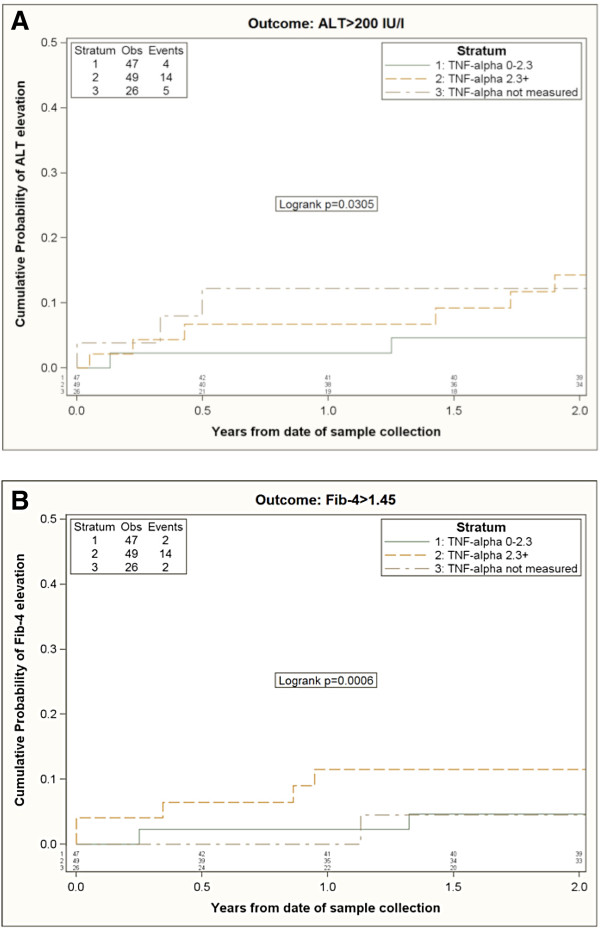
Kaplan-Meier estimates of the risk of ALT elevation (A) and Fib-4 elevation (B) according to TNF-alpha strata. Kaplan-Meier plots were used to compare the cumulative percent of patients reaching the primary endpoint. The cohort was stratified according to TNF-alpha plasma levels above or below the median (i.e. 2.3 pg/ml).